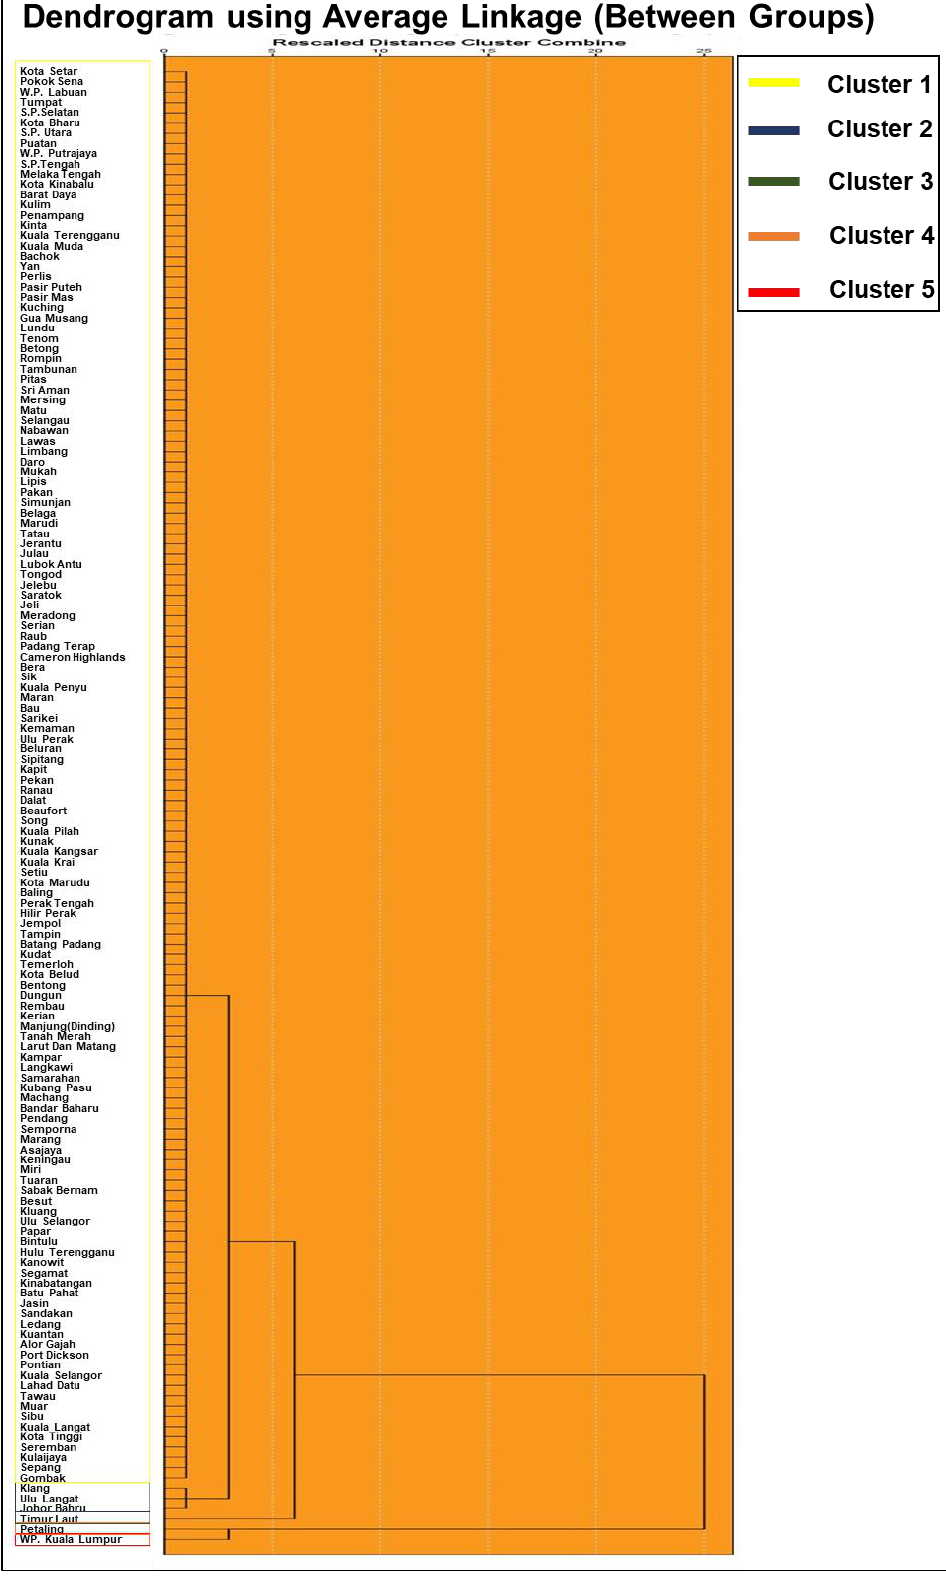
Figure 4. Dendrogram of cluster analysis that taxonomized COVID-19 cases and population density according to districts by average linkage method.